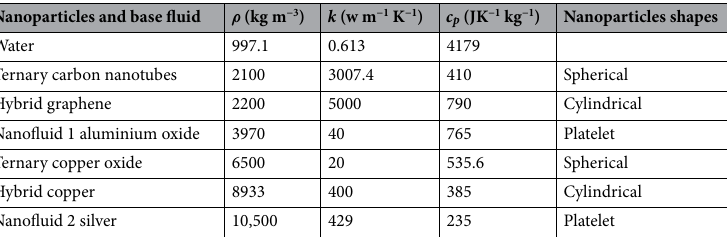
Nanoparticles and base